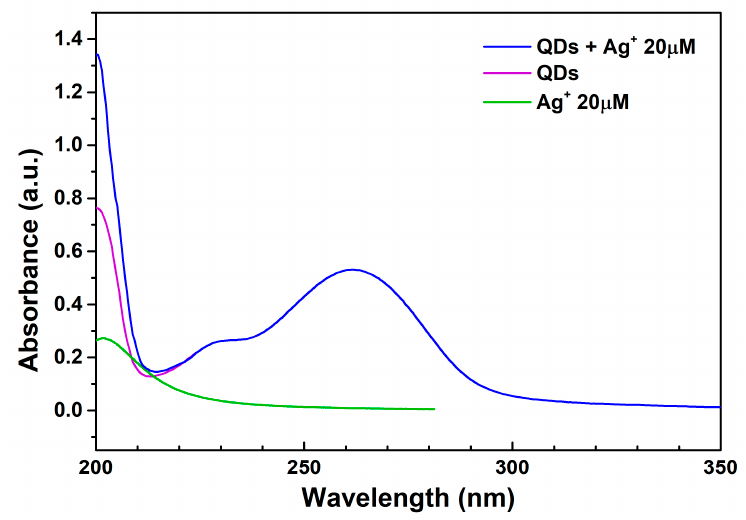
Figure 4. UV–Vis absorption spectra of bare N-CQDs solution (middle, violet), N-CQDs solution containing [Ag + ] = 20 m (top, blue) and of a [Ag + ] = 20 m water solution.